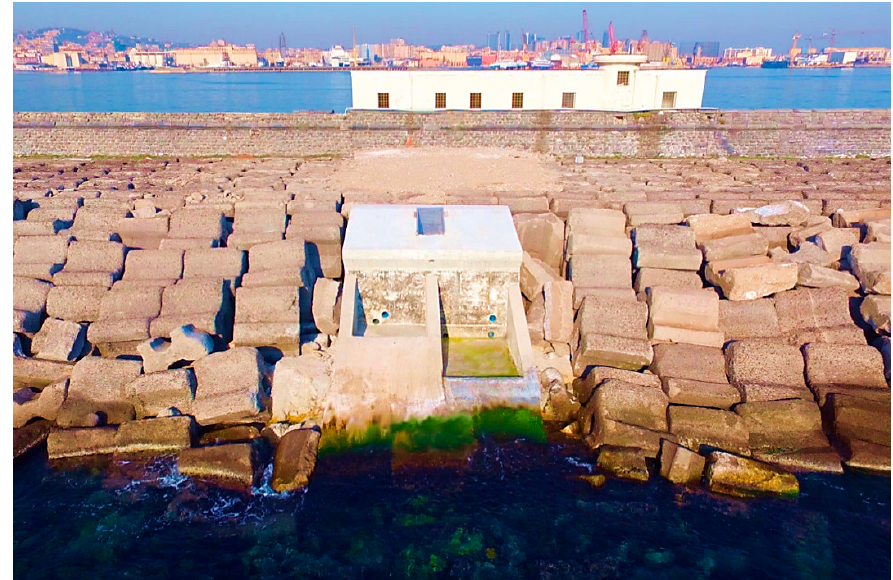
Figure 13. The OBREC prototype installed in the San Vincenzo breakwater, port of Naples.